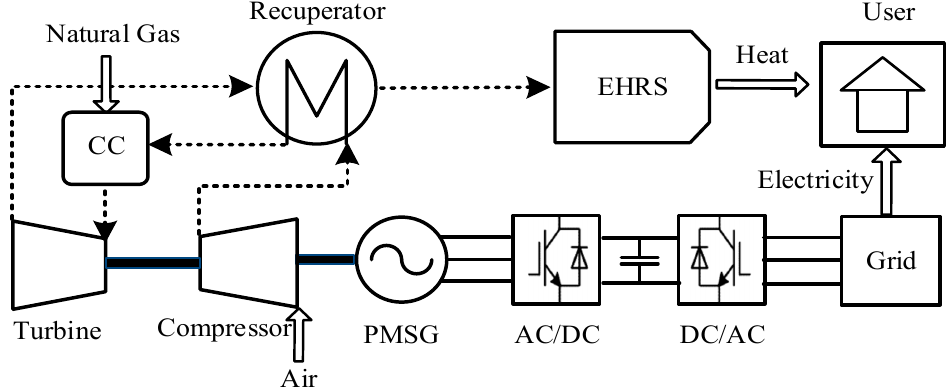
Figure 1. Structure and energy flow of the grid-connected combined heat and power (CHP) system.